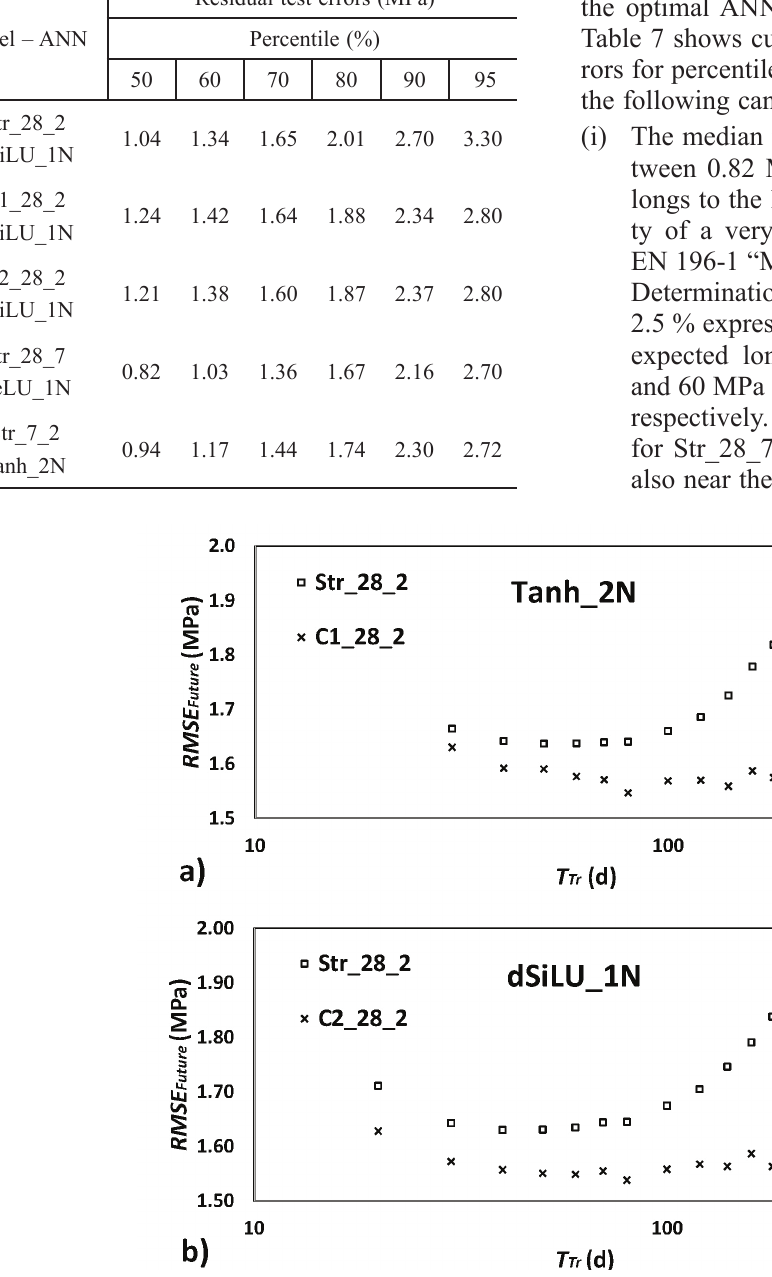
Fig. 15 – Comparison of RMSE